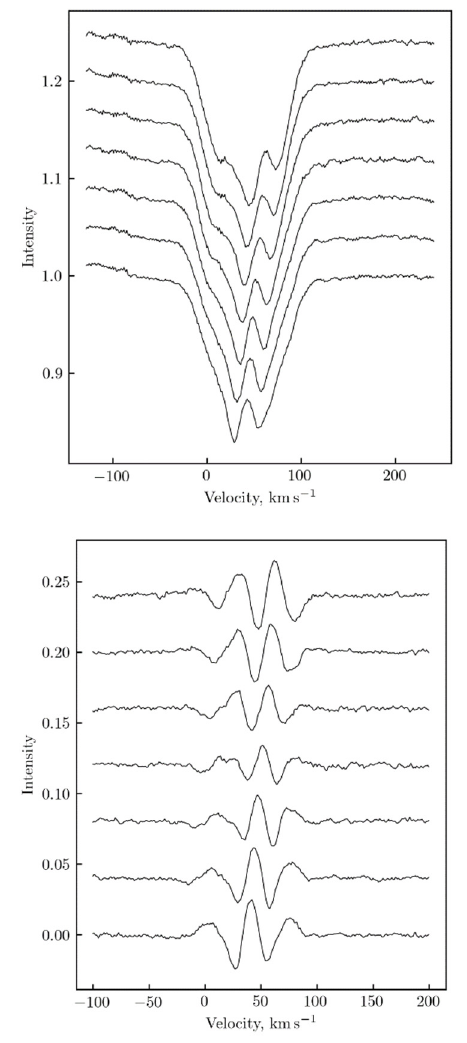
Fig. 3 . The discovery of high-degree prograding non-radial mode pulsations in VY Hya. Left: Line-profile variations in LSD profiles. Right: Line-profile variations in the residual